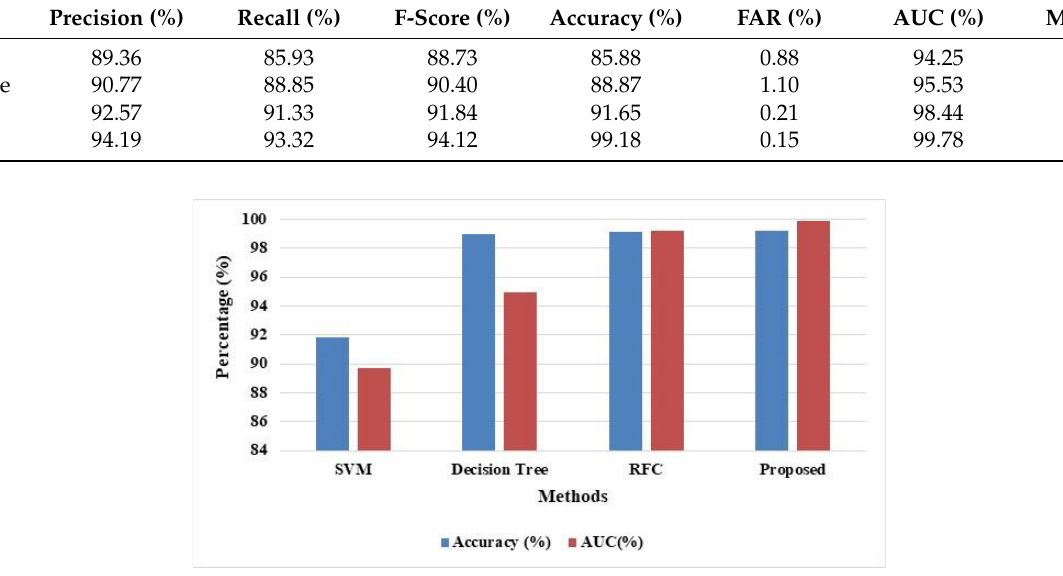
Figure 7. Performance evaluation for the proposed SMO-HPSO for UNSW NB-15 Dataset.